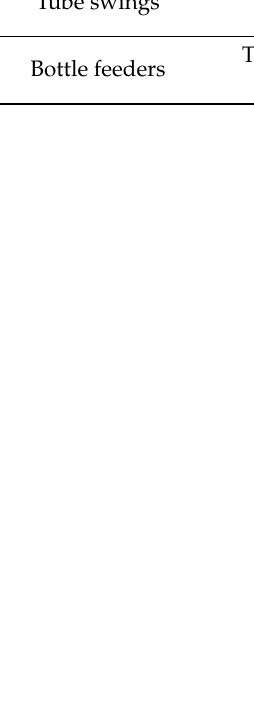
Table 4. Ethogram followed by the researchers, with the definition of each